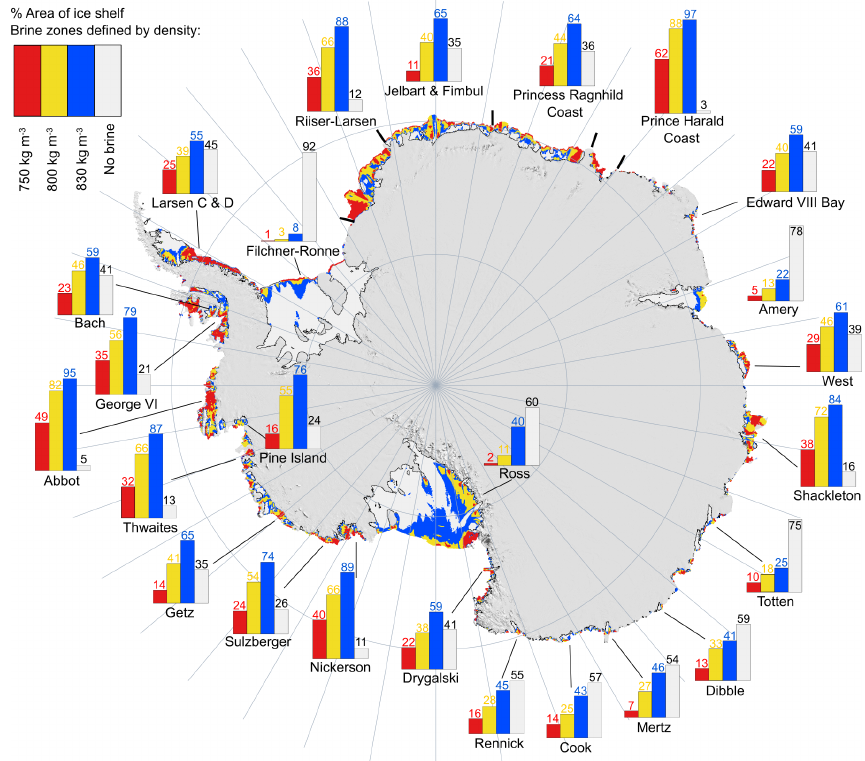
Figure 1. Map of potential brine zones areas around Antarctica. Map shows areas where permeable firn lies below sea level (the brine zone), with the threshold for firn permeability defined as 750kgm − 3 (red), 800kgm − 3 (yellow) and 830kgm − 3 (blue) calculated using Bedmap2 surface elevation. Bar charts show the mean percentage area of selected ice shelves covered by the brine